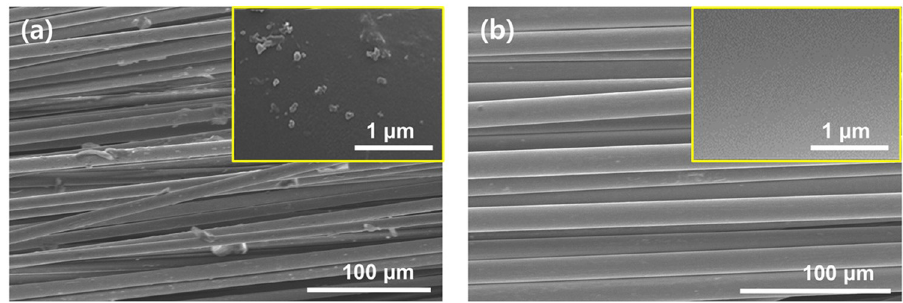
Figure 3: Surface morphology of BFs and OBFs: ( a ) SEM images of BFs and ( b ) OBFs.